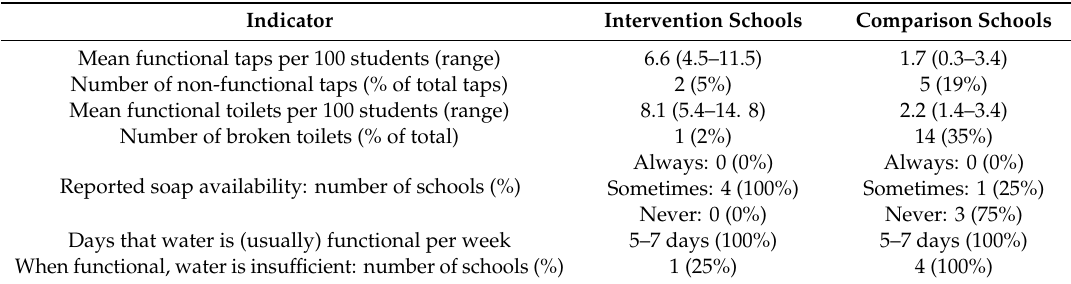
Table 1. Audit of water and sanitation facilities in intervention and comparison schools.